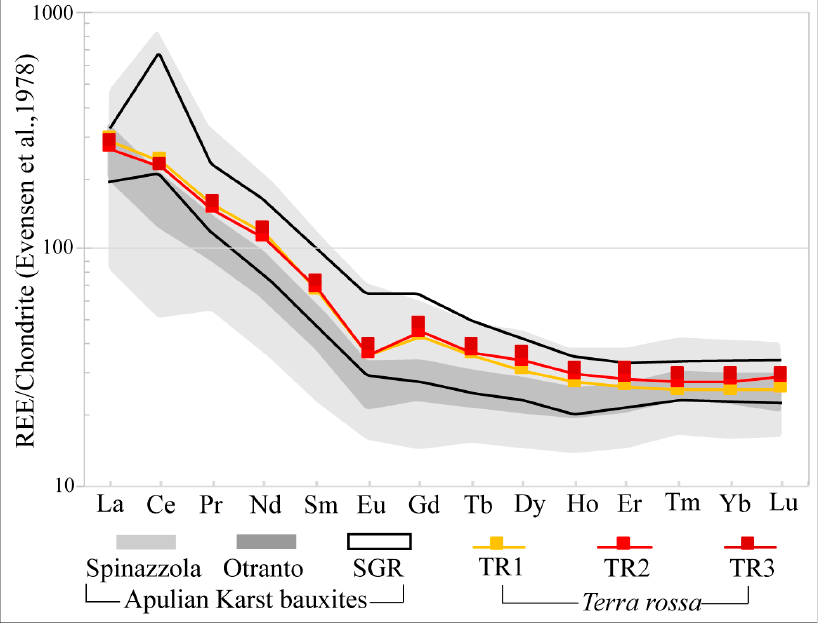
Figure 9. REE pa tt erns normalized to chondrite [40] for studied fi ne-grained portion of terra rossa ( n = 3) compared to literature data for Apulian bauxites [14,15,18]. ( n = 3) compared to literature data for Apulian bauxites